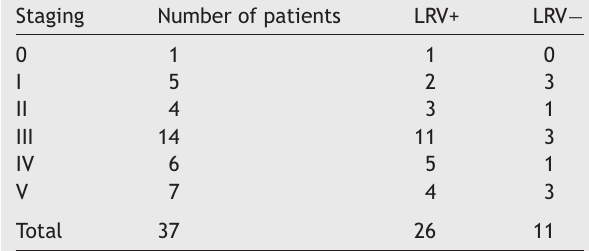
Table 5 Clinical staging system for patients’ nasal mucosa.